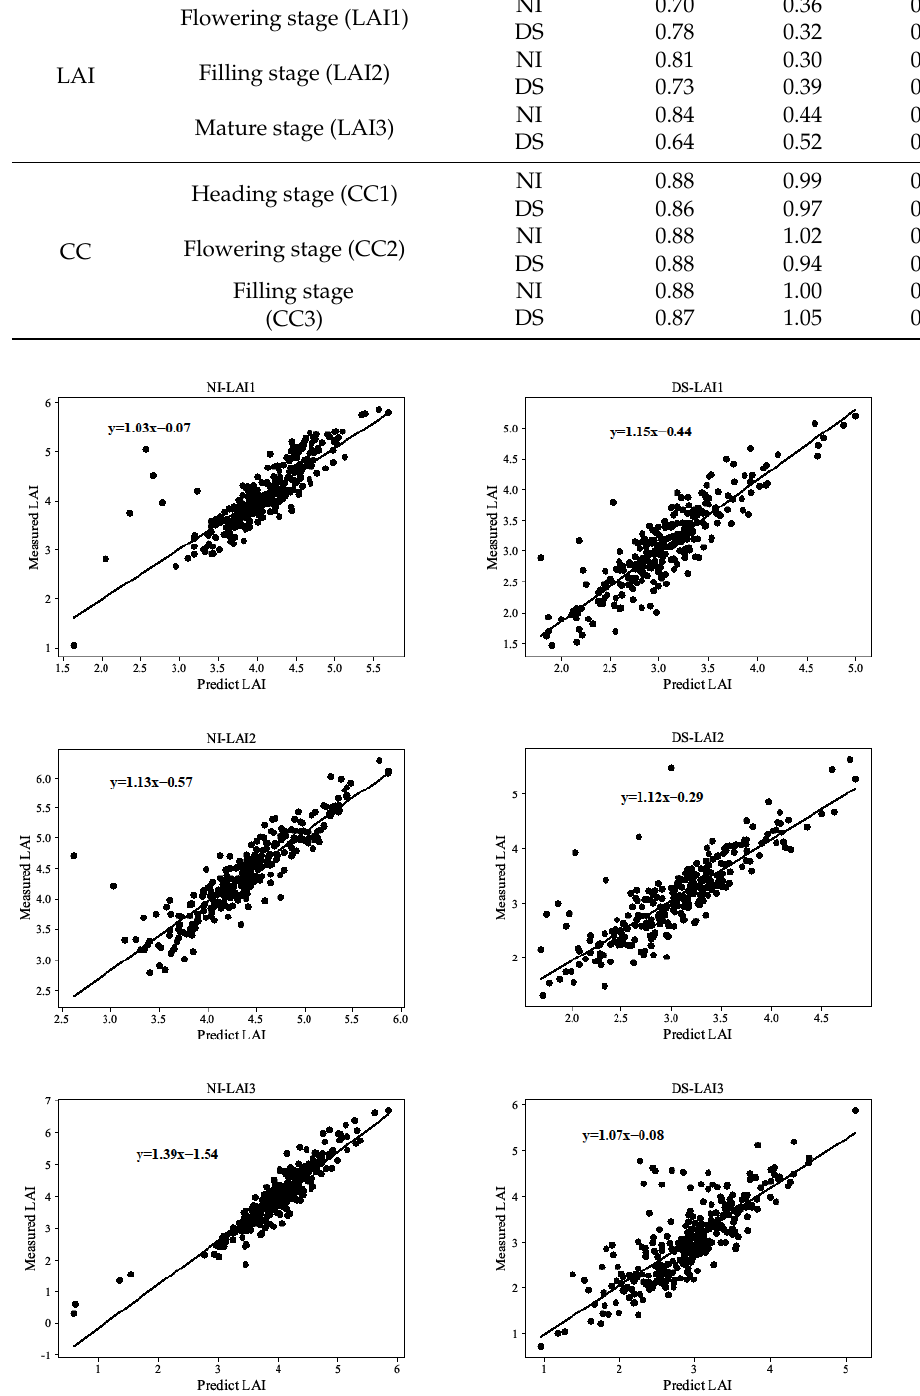
Figure 2. The relationship between the predicted and the measured leaf area index (LAI) values at three wheat growth stages, flowering (LAI1), filling (LAI2), and maturity (LAI3), under normal irrigation (NI) and drought stress (DS)